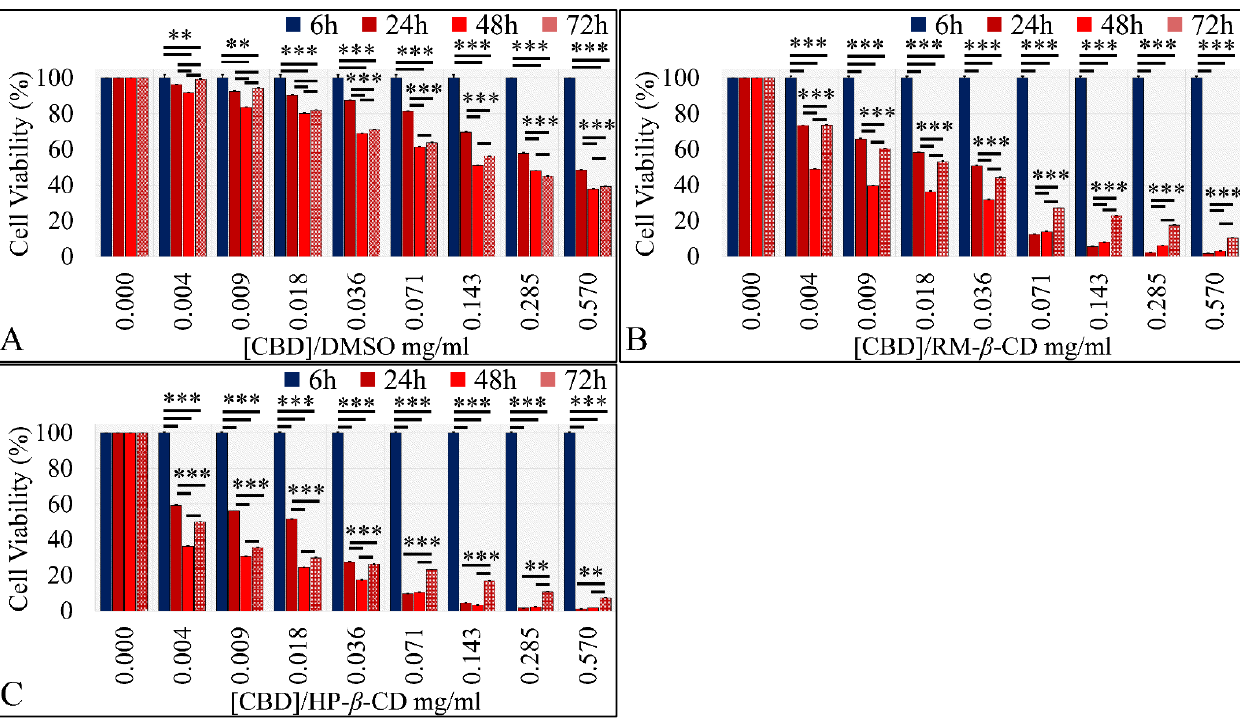
Figure 12. Dose-dependent effect of CBD and CBD inclusion complexes on TE671 cells. ( A ) CBD/DMSO exhibited a significant effect at all concentrations in a dose-dependent manner; ( B ) CBD/RM- β -CD complex; and ( C ) CBD/HP- β -CD demonstrated significant differences in a dose-dependent manner at all hours. ** depicts a significance at the p < 0.01 level and *** depicts a significance at the p < 0.0001 level. Each value represents the mean ± SD of triplicate experiments.